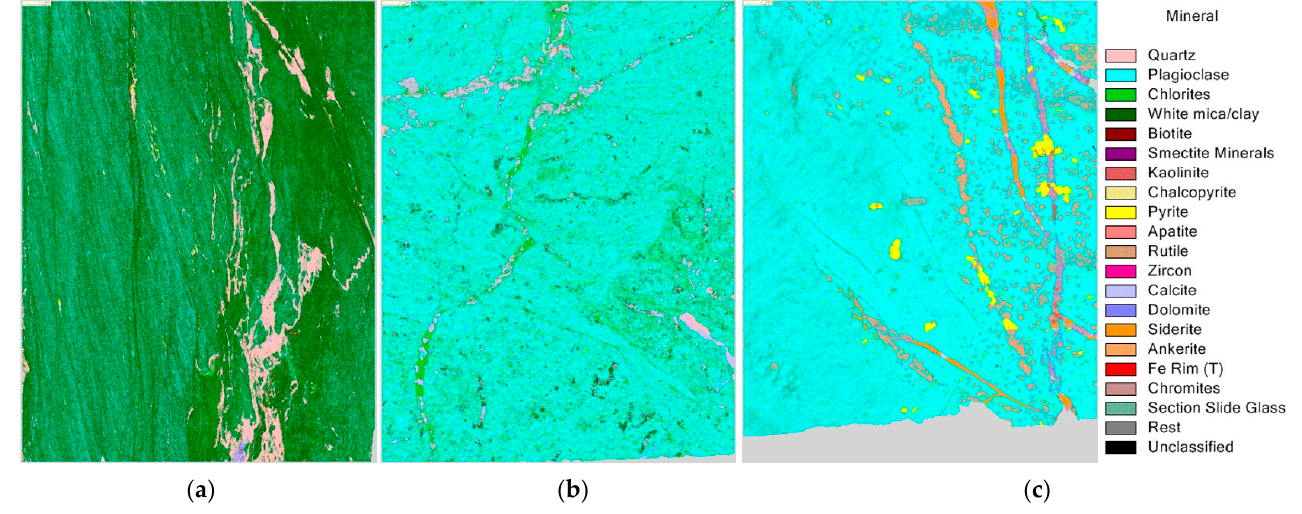
Figure 4. Mineral map by QEMSCAN analysis showing the distribution minerals in the ( a ) least altered phyllite, ( b ) albite–chlorite alteration zone, and ( c ) albite–ankerite–pyrite alteration zone. (Plagioclase = albite, white mica = muscovite.) Table 1. Mineral quantification from different alteration zones measured by QEMSCAN.